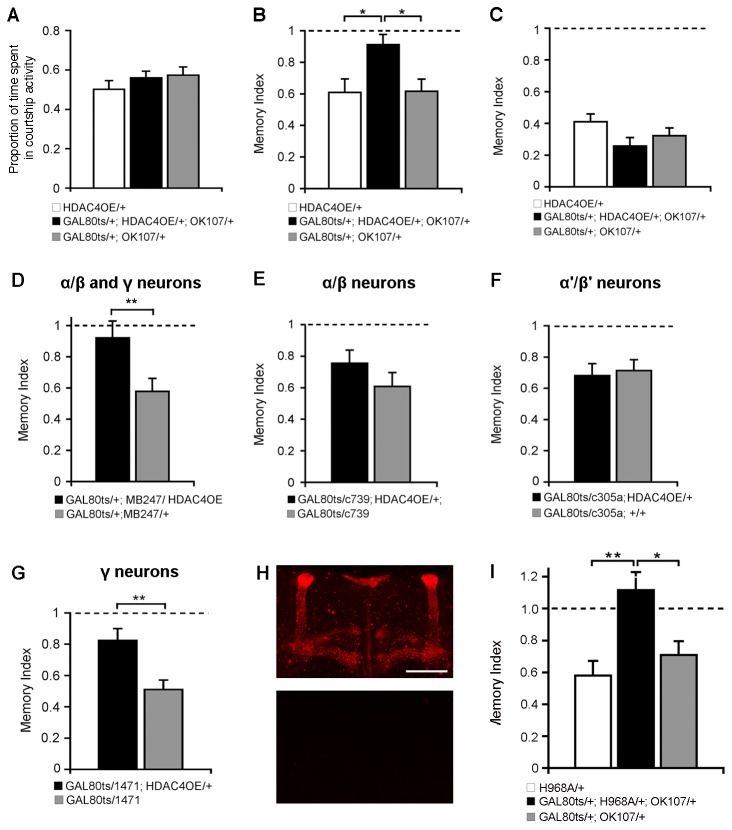
Overexpression of HDAC4 impairs LTM.In all cases, HDAC4 expression was restricted to the adult brain with the TARGET system. A, B. Courtship activity of naïve males was not altered by OK107-GAL4 mediated overexpression of HDAC4 (ANOVA, p=0.377) (A), but LTM was significantly impaired (ANOVA, post-hoc Tukey’s HSD, *p<0.05) (B). C. STM tested one hour following a one-hour training session was not significantly different between control and HDAC4-overexpressing males (ANOVA, p=0.12). D. Overexpression with α/β and γ lobe driver MB247 significantly impaired LTM (Student’s t-test, two-tailed, unpaired, **p<0.01). E. No significant impairment in LTM occurred when MB expression of HDAC4 was restricted to the α/β lobes with the c739 driver (Student’s t-test, two-tailed, unpaired, p=0.156). F. LTM was also not impaired when FLAG-HDAC4 was expressed in the α'/β' lobes with the c305a driver (Student’s t-test, two-tailed, unpaired, p=0.630), G. 1471-GAL4 driven expression of FLAG-HDAC4 in the γ lobe resulted in a significant LTM deficit (Student’s t-test, two-tailed, unpaired, **p<0.01). H. OK107-GAL4 mediated expression of FLAG-HDAC4 H968A was induced in adult brains with the TARGET system. Whole-mount brains were processed for immunohistochemistry against FLAG, which detects HDAC4 H968A in the mushroom body (upper image). No expression was observed when flies were raised and maintained at 19°C (lower image). Scale bar = 50 μm. I. Expression of HDAC4 H986A in the MB impaired LTM (ANOVA, post-hoc Tukey’s HSD *p<0.5, **p<0.05).